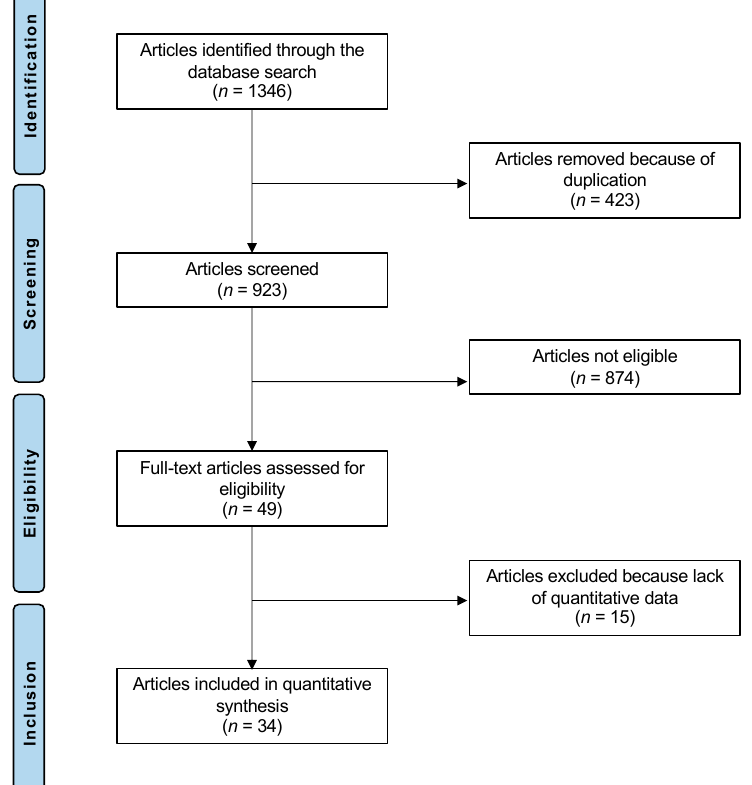
Figure 1. Flow chart of the number of literature search results.